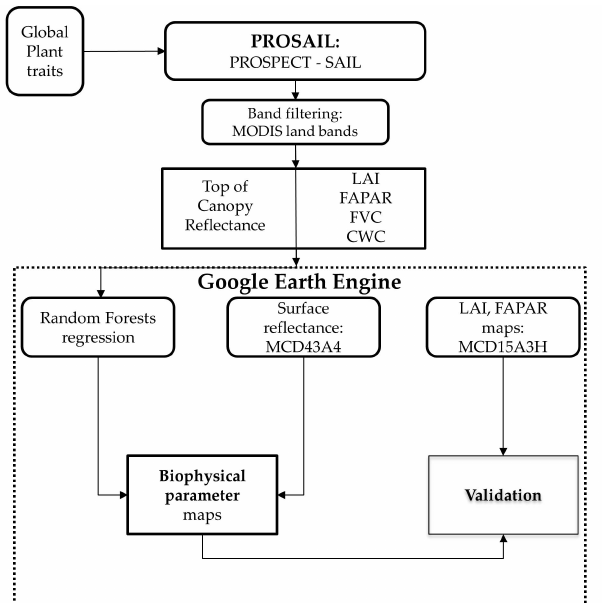
Figure 1. Work flow of the proposed retrieval chain over GEE.